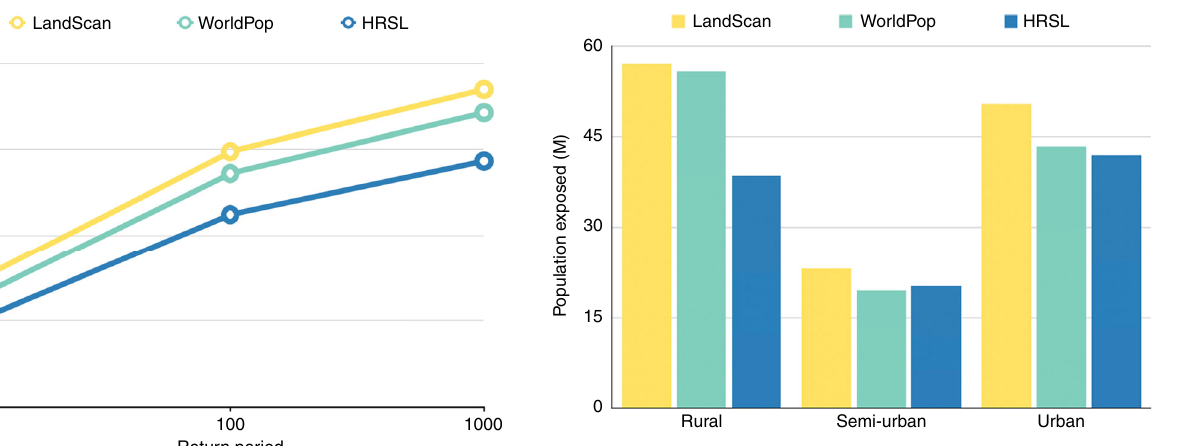
Fig. 4 Exposure across different land use types. Total population exposed to fl ooding across rural, semi-urban, and urban areas